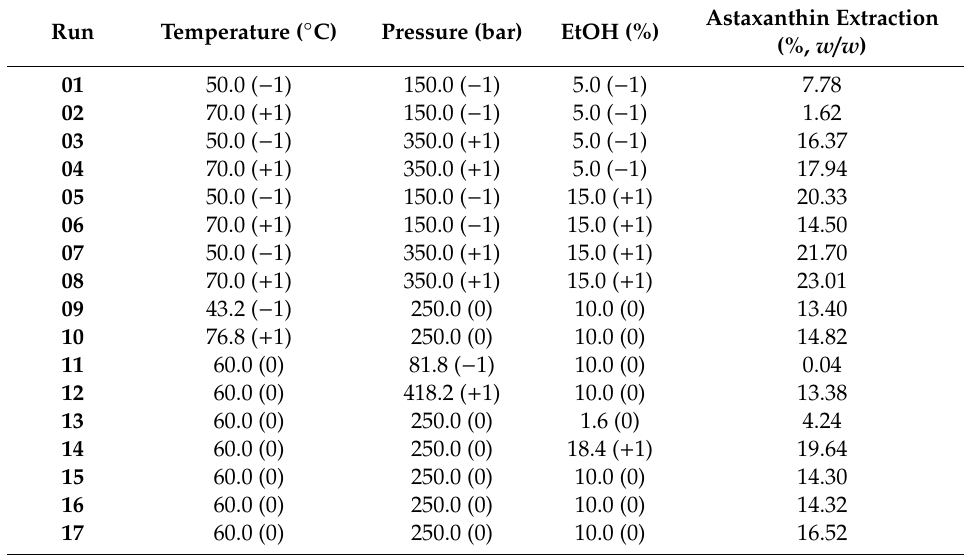
Table 3. E ff ect of temperature, pressure, and co-solvent concentration (ethanol) on astaxanthin extractability (%, w / w ) of X. dendrorhous Accellerase-pre-treated